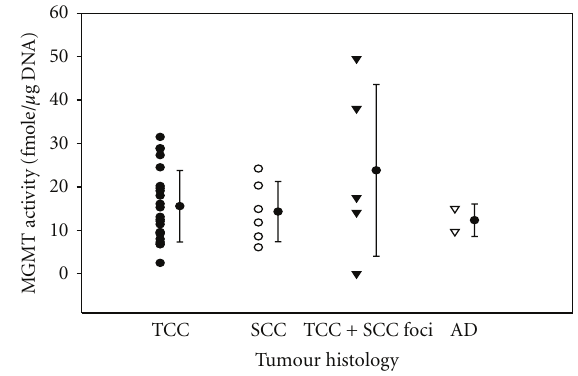
Figure 2: Relationship between MGMT activity (fmole/ µ g of cellular DNA: means indicated by asterisks, error bars indicate standard error) and tumour histology. TCC, transitional cell carcinoma; SCC, squamous cell carcinoma; AD,